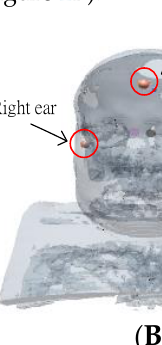
Figure 1. The architecture diagram.